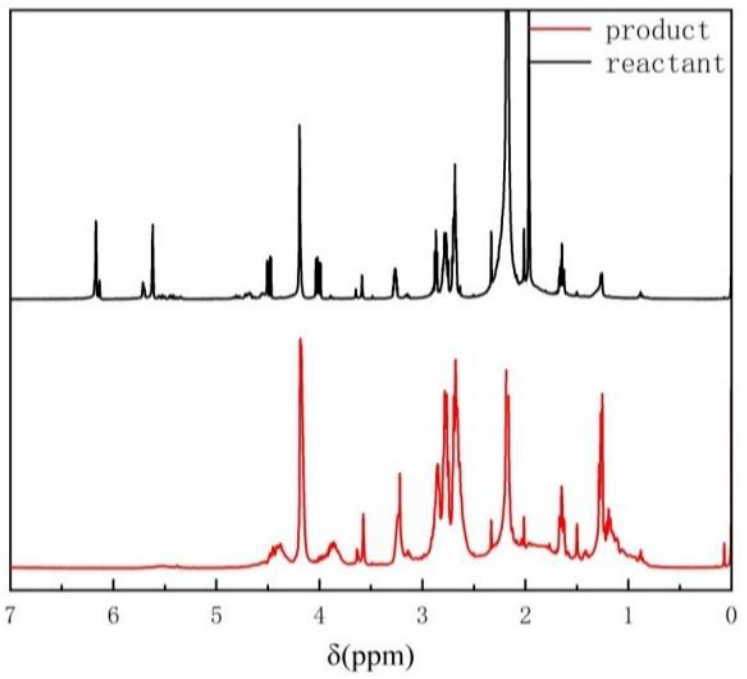
Figure 4. 1H-NMR spectra of the reactants (mixture of PFDA, GMA and PETMP) and product (fluorinated epoxy).